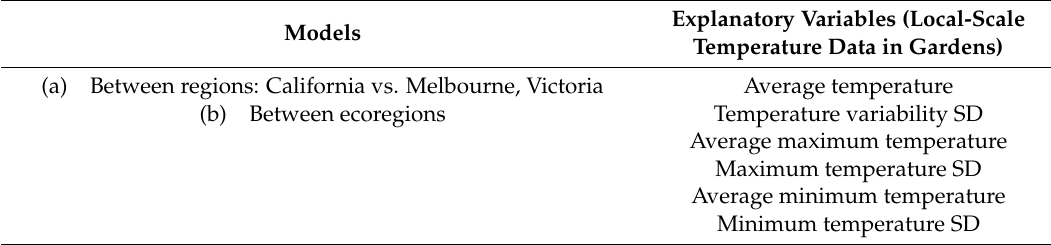
Table 2. Structure of linear mixed-effects models to examine differences in the local-scale weather data collected in the garden plots between regions (a) and among ecoregions (b) in the